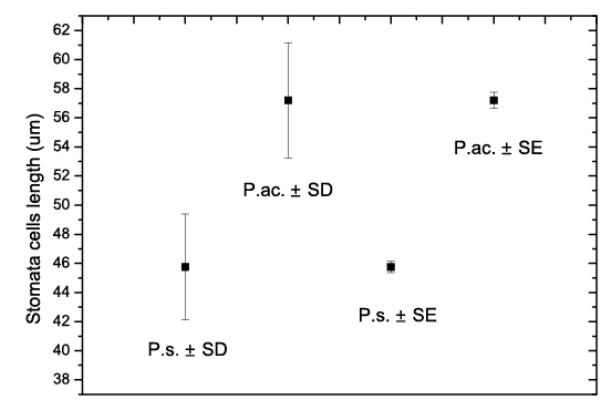
Figure 5 Length of stomata cells (guard cells) of Polystichum setiferum (P.s.) and P. aculeatum (P.ac.) from the stand in the Beskid Śląski. e means ± SD and ± SE ( n = 100) are shown.